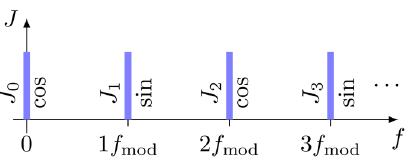
Figure 2. Resulting spectrum of the sensor signal (cid:1871) with a modulated measuring mirror and a modulation frequency (cid:1858) (cid:3040)(cid:3042)(cid:3031) .